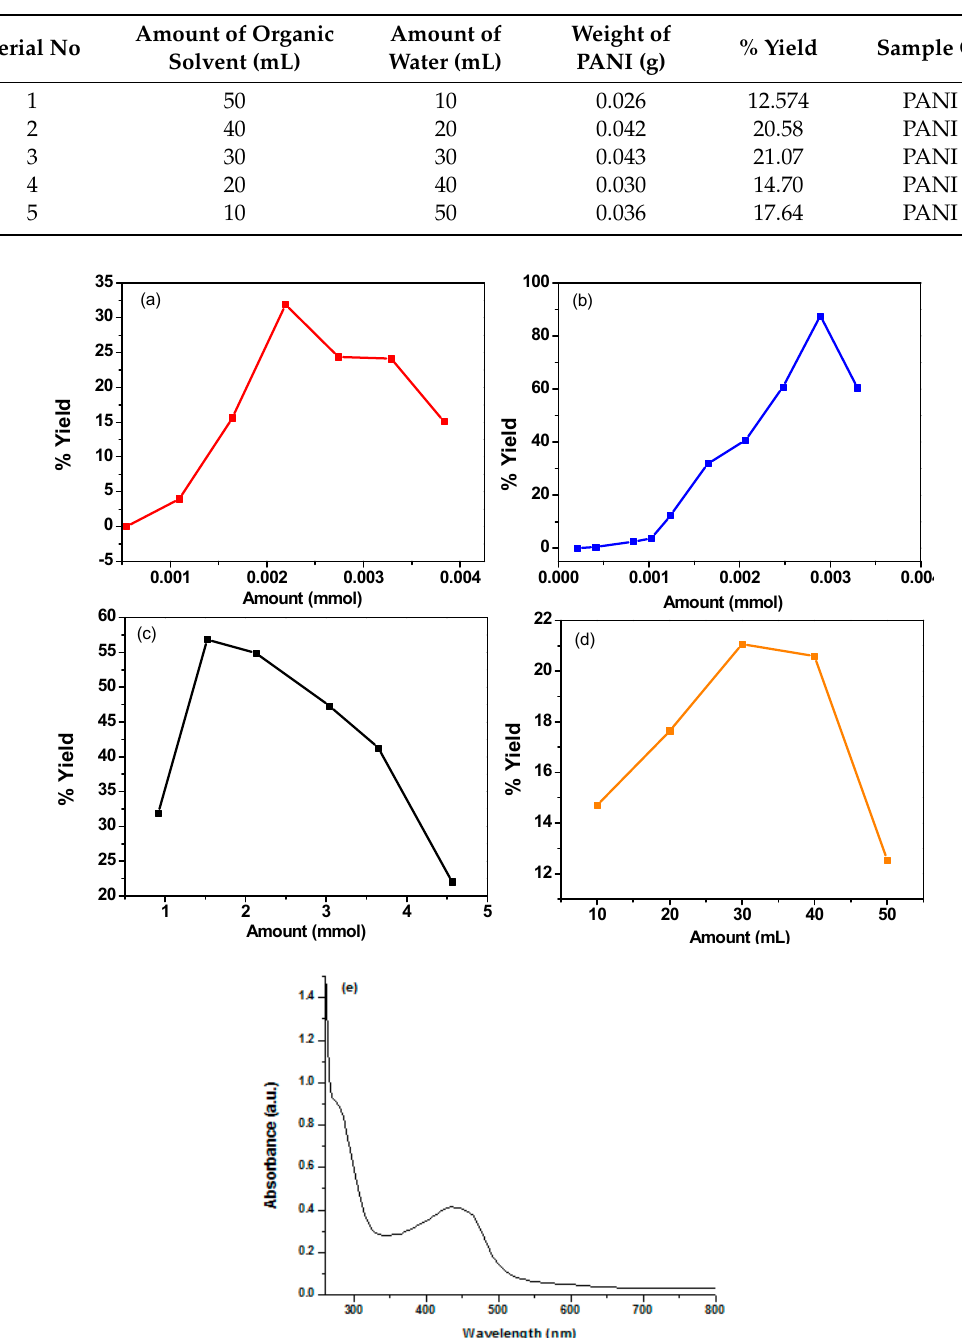
Figure 1. Effect of different reaction parameters on % yield of PANI ( a ) Amount of monomer, ( b ) Amount of Oxidant, ( c ) Amount of dopant in mmol, ( d ) Amount of solvent in mL, and ( e ) UV/Visible spectrum filtrate from product washing indicating the presence of oligomers.